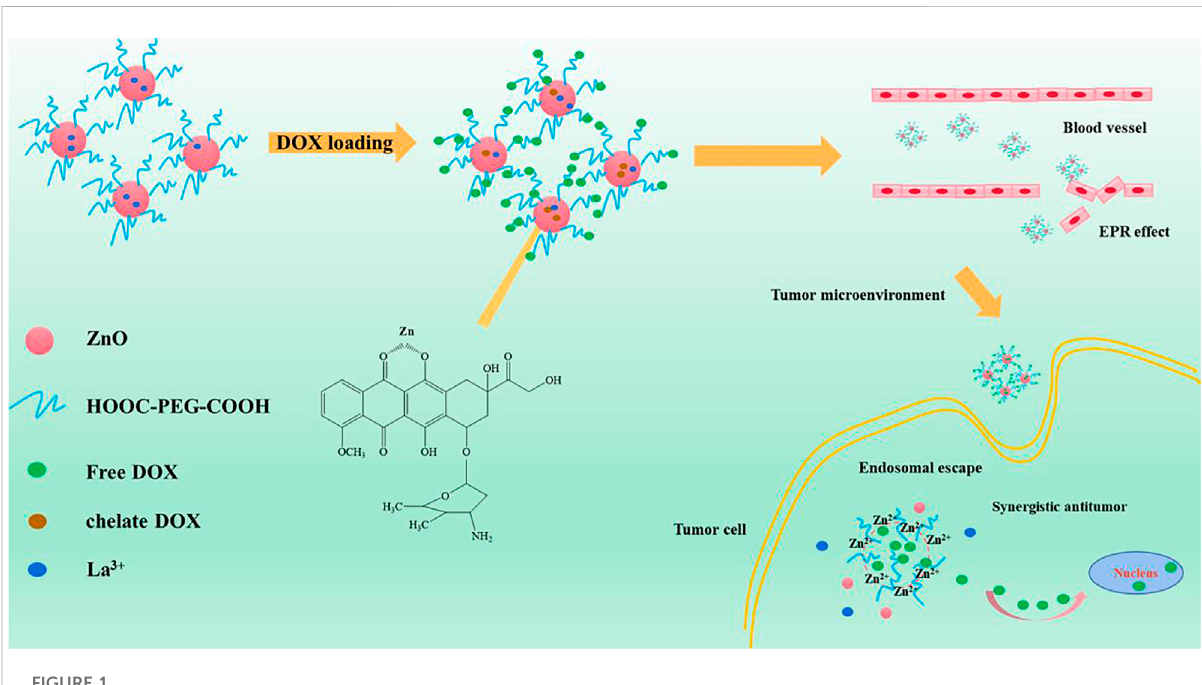
FIGURE 1 Schematic illustration of the preparation of PEG-HA-La-ZnO and its antitumor effects investigate in both in vitro and in vivo .